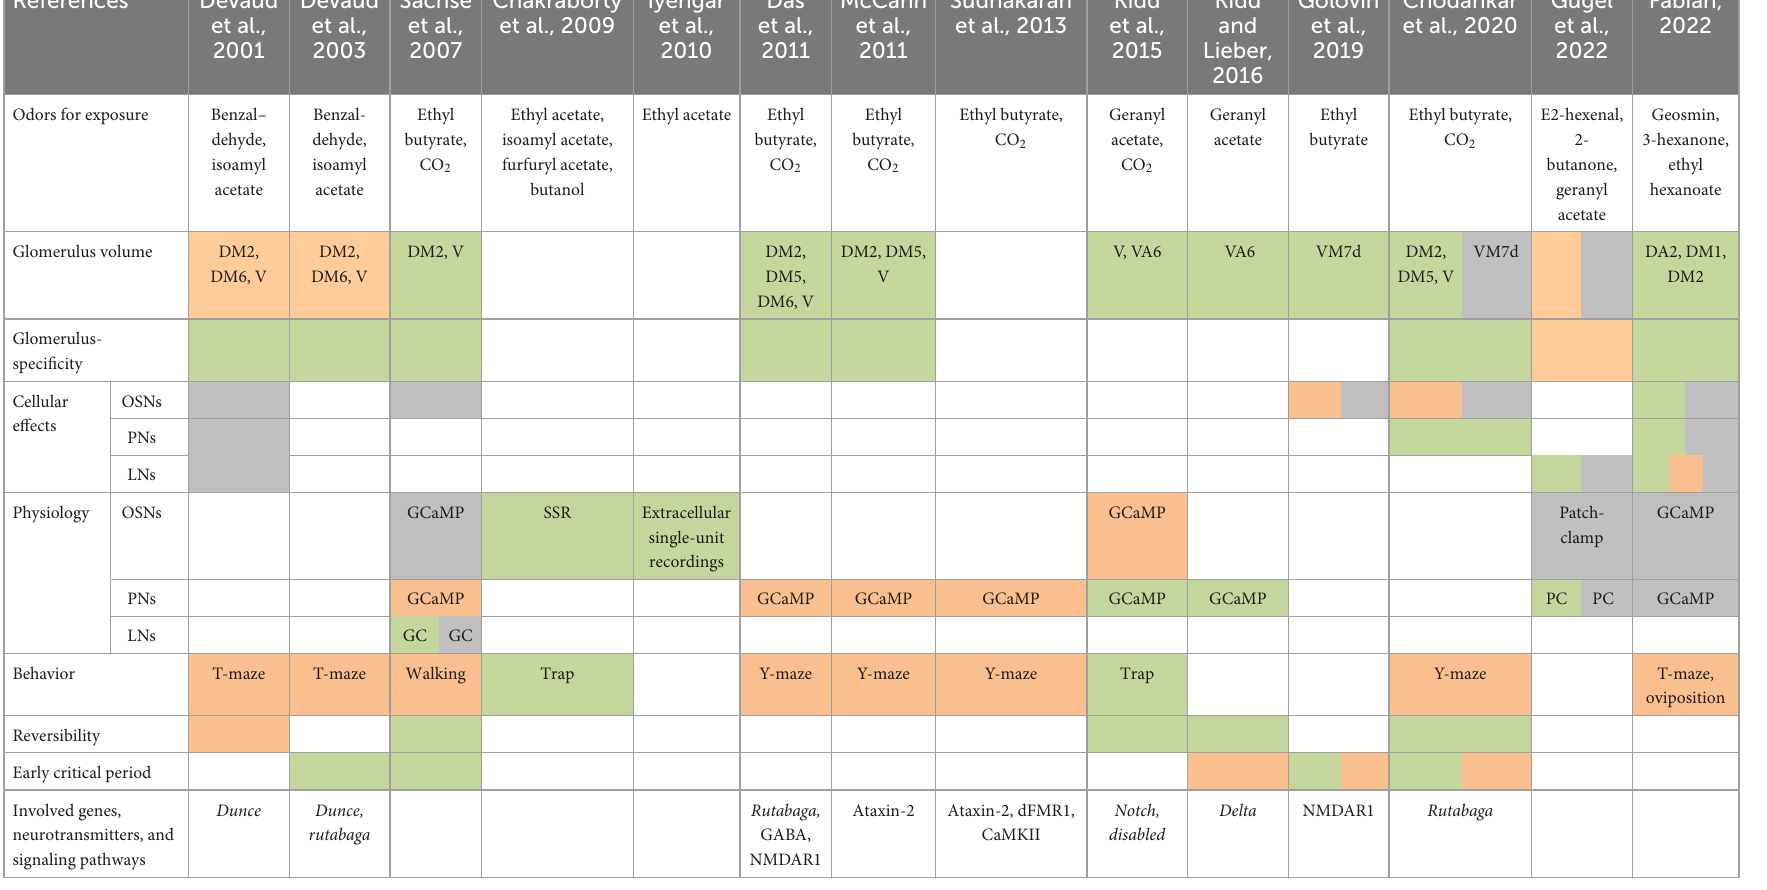
Colored tiles indicate experiments that were done in the respective studies. Green, a phenomenon was observed (e.g., glomerulus-specificity) or there was an increase in the measured parameter (e.g., glomerulus volume); orange, a phenomenon was not observed (e.g.,